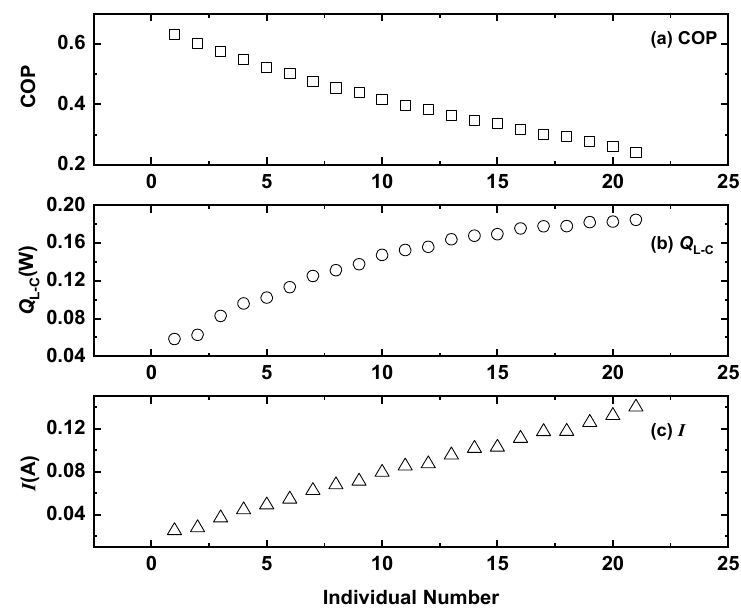
Figure 10. Performance variation with different individual solution: ( a ) cooling capacity; ( b ) COP; and ( c ) electrical current.